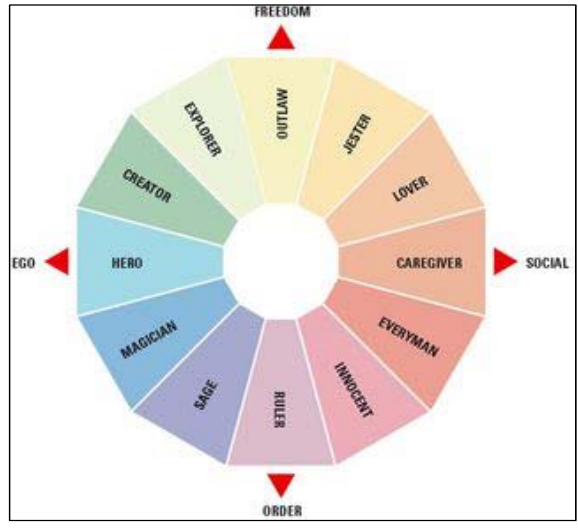
Figure 1. Archetypes [26].